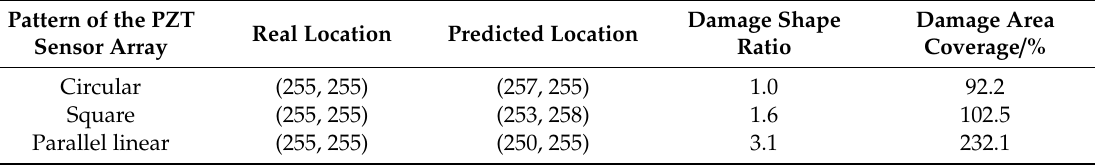
Table 1. The resultant imaging accuracy of a hole with three PZT sensor array